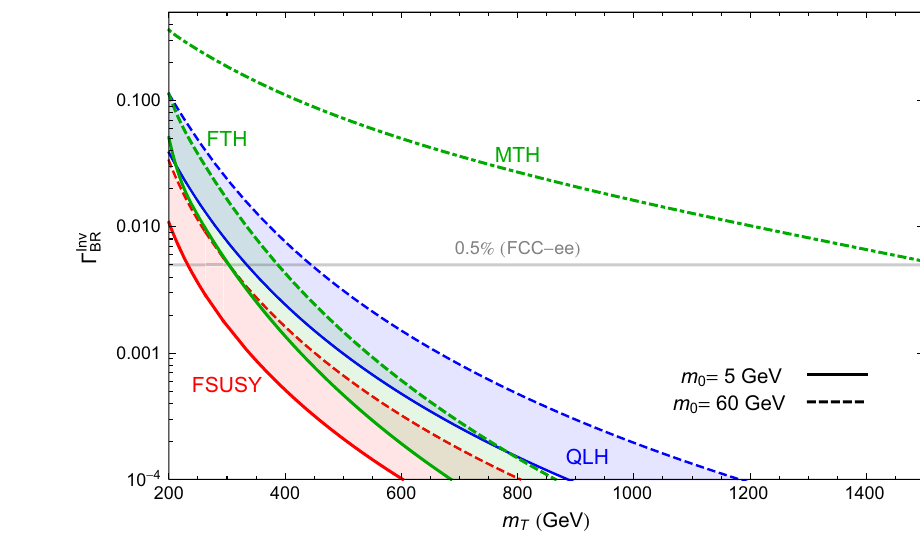
Fig. 9.4 Higgs boson branching ratio into hidden sector glueballs as a function of top partner mass in a variety of Neutral Naturalness